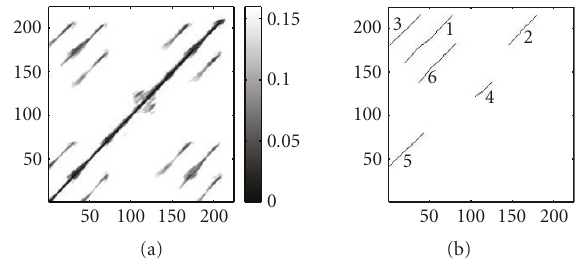
Figure 10: Shostakovich example of Figure 2. (a) S min 16 [41,10]. (b) ... , P P = { P } based on the same parameters as in the Brahms 1 , 6 example of Figure 9. The index m of P m is indicated along each re- spective path.